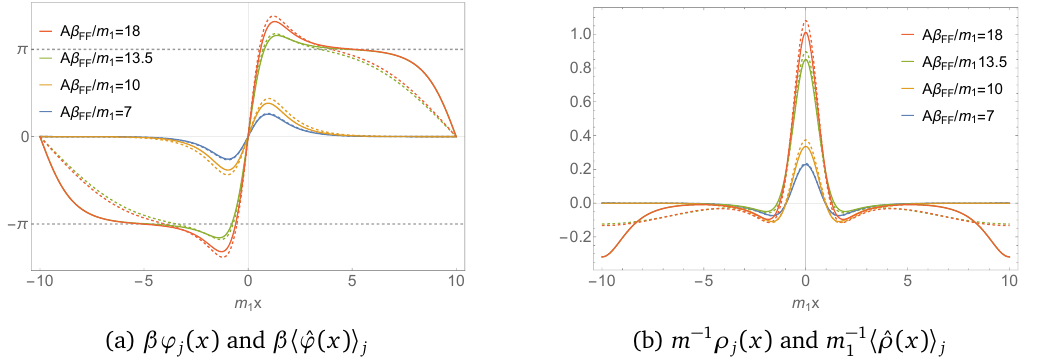
Figure 4.4: Comparing classical and quantum profiles for a fixed interaction β and varying amplitudes A , with (a) showing the QFT expectation values 〈 β ˆ ϕ ( x ) 〉 and j ( x ) , while (b) displaying the topolo- the classical lowest energy configurations βϕ j 〈 ˆ ρ ( x ) 〉 ( x ) . Continuous lines correspond to the gical charge densities m − 1 and m − 1 ρ j j 1 classical case, while quantum results are shown with dashed lines. The parameters (cid:112) / σ = 2 / 3; different A values are shown L = 20, m = m are (cid:96) = m , β = β 2, m 1 1 FF 1 with different colours. The classical solutions for the two largest A values have zero mode βϕ ( 0 ) = π and are shifted by − π . The TCSA profiles 〈 ˆ ρ ( x ) 〉 were extrapol- j = 24,26,28 and 30, and the profiles β 〈 ˆ ϕ ( x ) 〉 ated using cut-offs e were obtained c j = β 〈 ∂ ˆ ϕ ( x ) 〉 by spatial integration of 2 π 〈 ˆ ρ ( x ) 〉 , requiring the result to vanish at j x j the origin x =